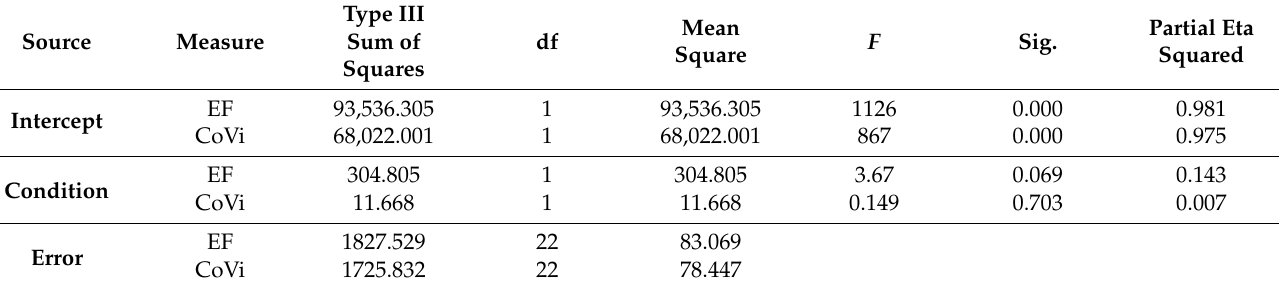
Table 3. Tests of between-groups effects measured over time.